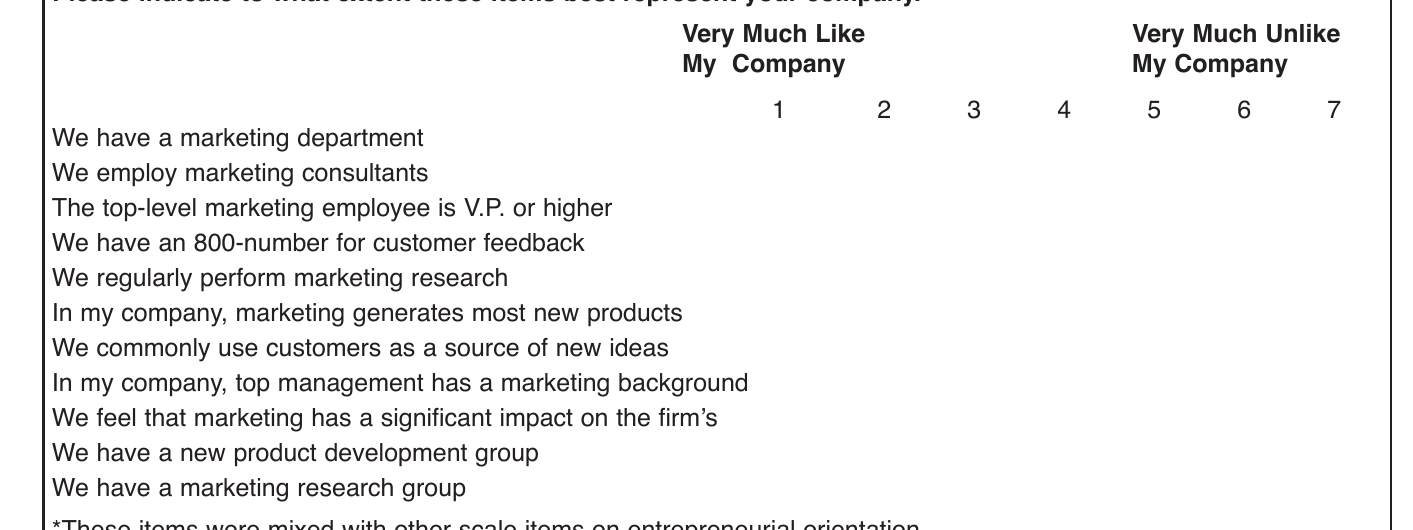
Figure 1. Marketing Orientation Scale